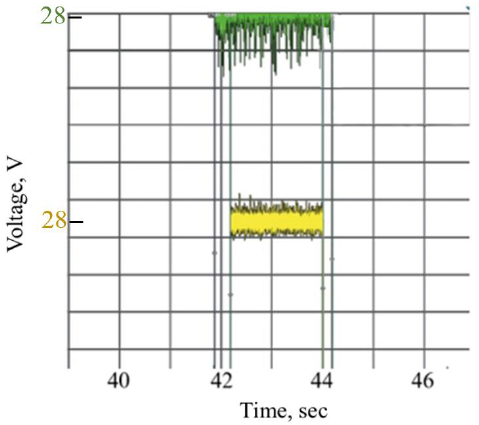
Figure 14. Dependence of the sensor hysteresis on the frontal distance: green — sensor installed at 2.5 mm, yellow — sensor installed at 3.5 mm.